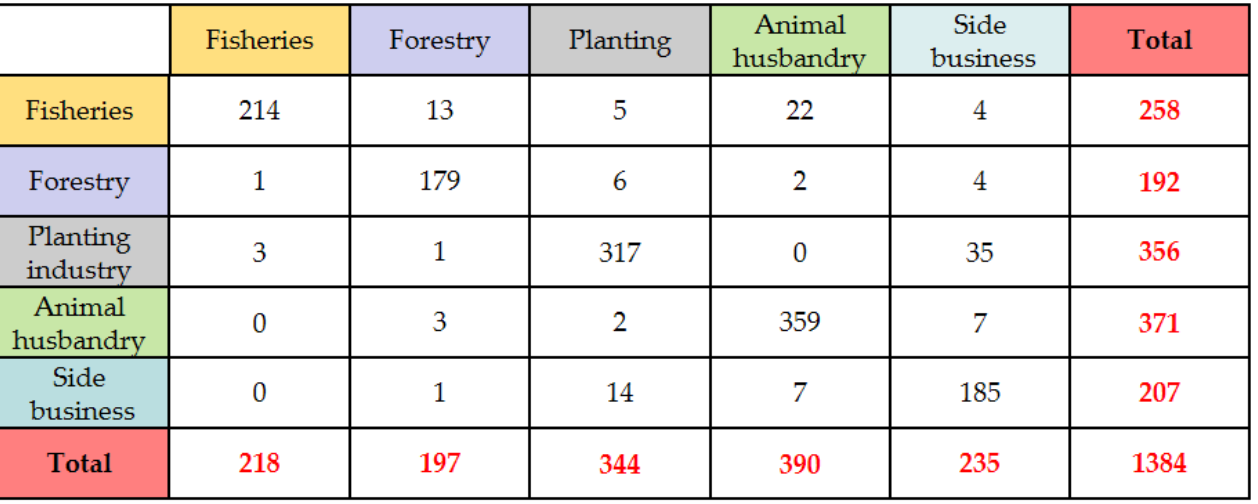
Figure 13. Confusion matrix for E3W.